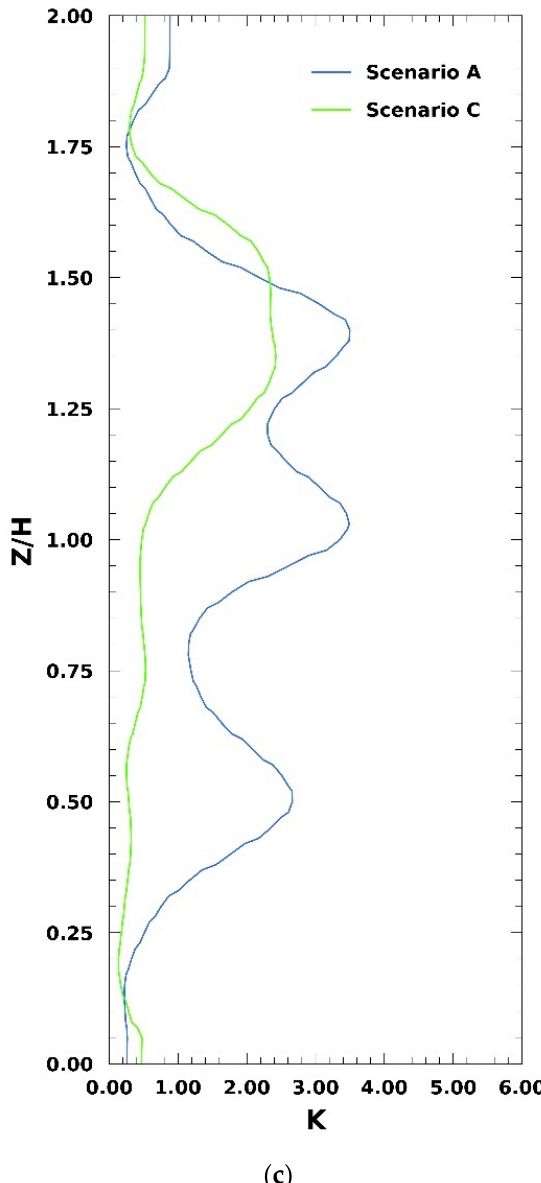
Figure 13. Vertical concentration profiles with the pollutant source at X = 7 H for Scenarios A and C at positions ( a ) (X: 7 H, Y: 5.5 H), ( b ) (X: 7.2 H, Y: 5.5 H), and ( c ) (X: 7.4 H, Y: 5.5 H).